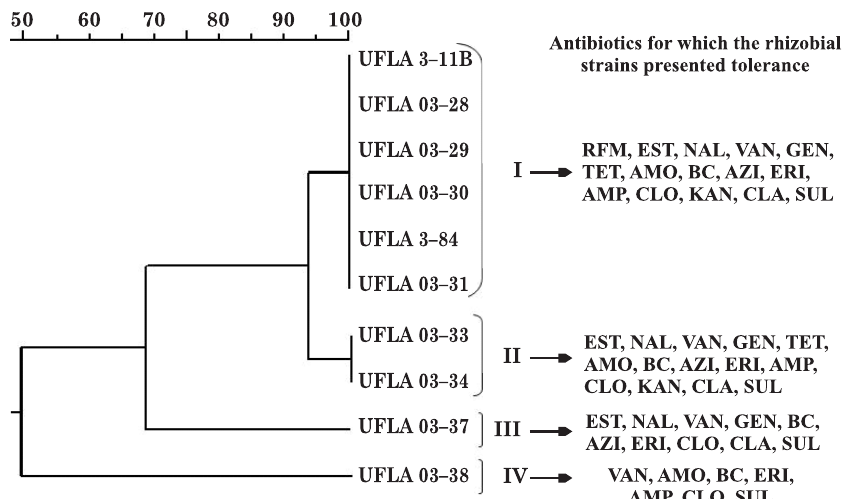
Figure 2. Dendrogram representing the relationships of the tolerance of the ten analyzed strains to the 15 antibiotics tested. amoxicillin (AMO), ampicillin (AMP), streptomycin (EST), gentamicin (GEN), azithromycin (AZI), clarithromycin (CLA), erythromycin (ERI), nalidixic acid (NAL), chloramphenicol (CLO), kanamycin (KAN), rifamycin (RFM), tetracycline (TET), vancomycin (VAN), sulfonamides (SUL) and Bacitracin (BC). Analysis was based on the UPGMA and Simple Matching (SM) algorithms.